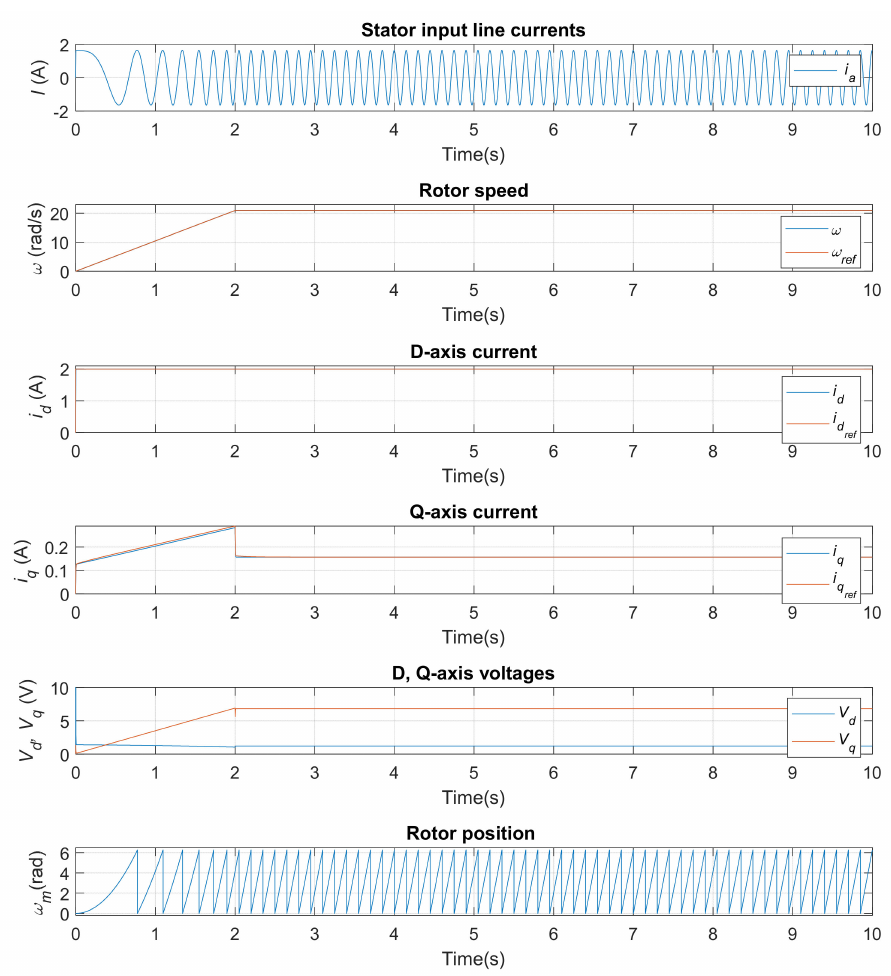
Figure 11. Simulation results of the startup ramp response of FOC of SynRM; I a : the measured phase a current, ω : the measures speed ( ω ) and the reference speed ( ω ref ), i d : the direct axis current ( i d ) and the direct axis current reference ( i dref ), i q : the quadrature axis current ( i q ) and the quadrature axis current reference ( i qref ), V dq : the direct and quadrature axis voltages, θ m : the mechanical angle of the